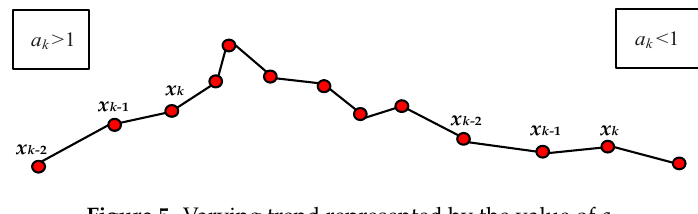
Figure 5. Varying trend represented by the value of a k.